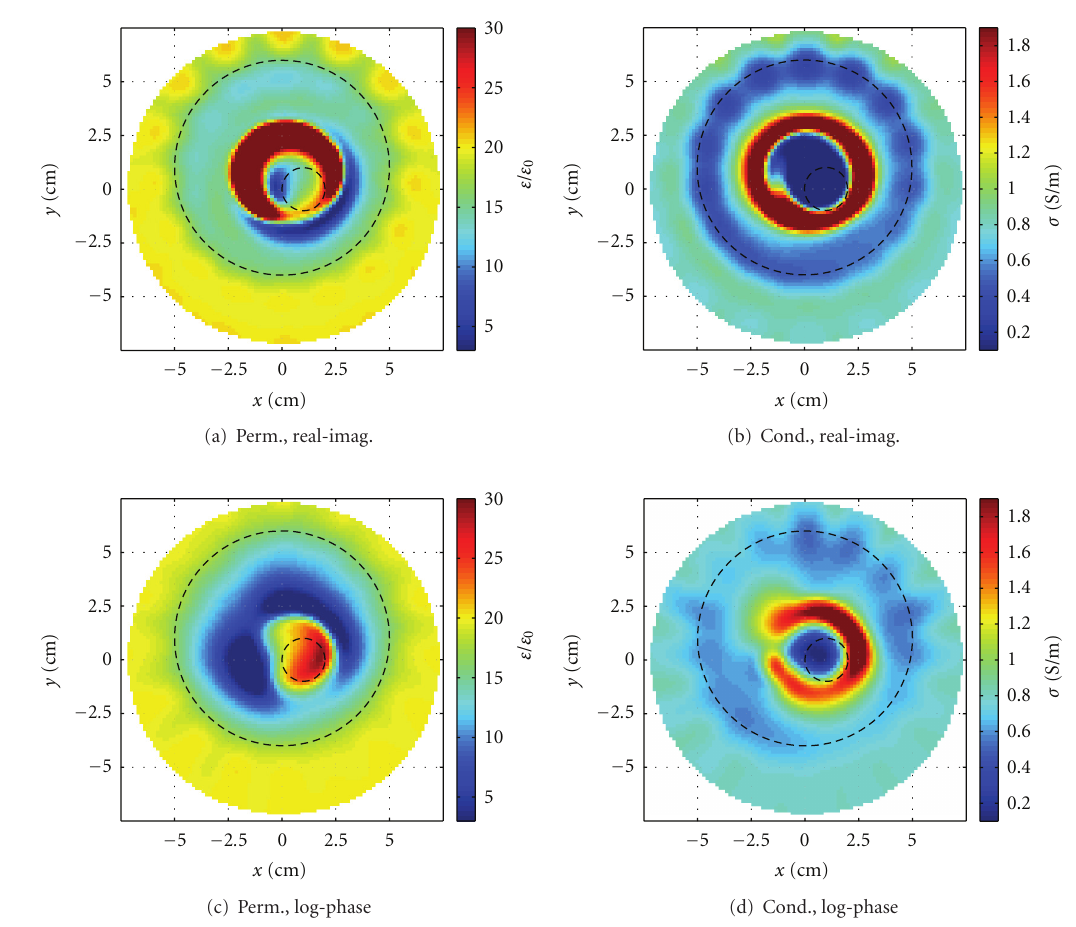
Figure 4: Reconstruction of the simulation no. 2. The dashed lines indicate the positions of the large and the small scatterers. A significant improvement is seen in the permittivity image when the log-phase formulation is used in the